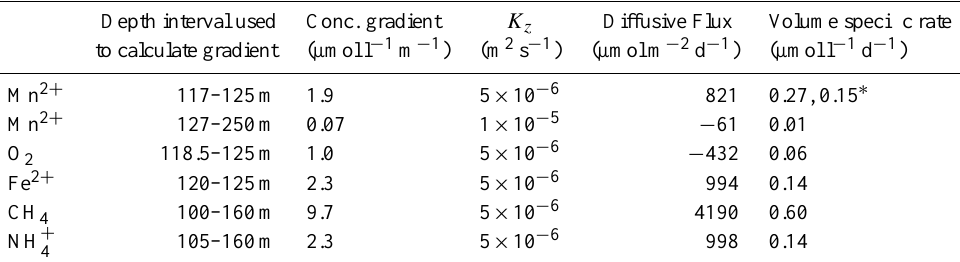
Table 7. Flux calculation parameters.